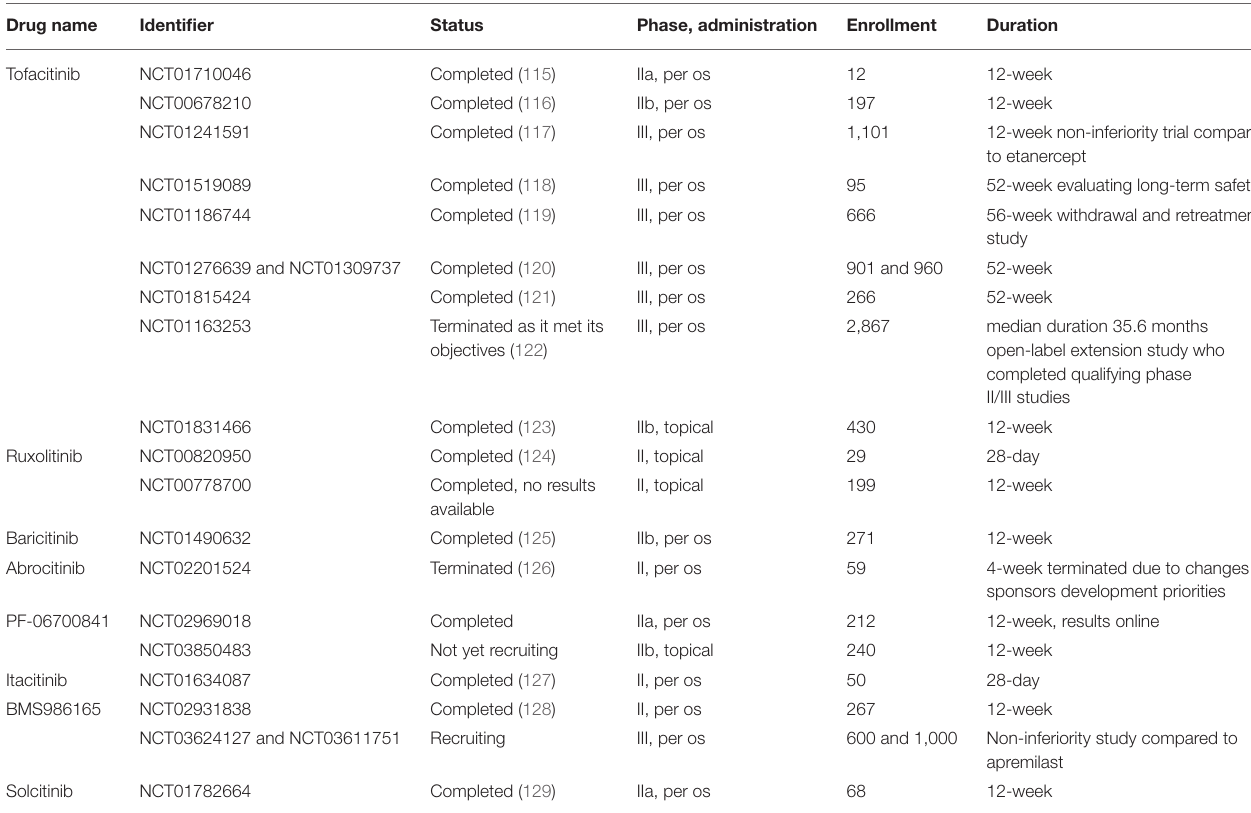
TABLE 4 | Phase II and III clinical trials studying Jak inhibitors in